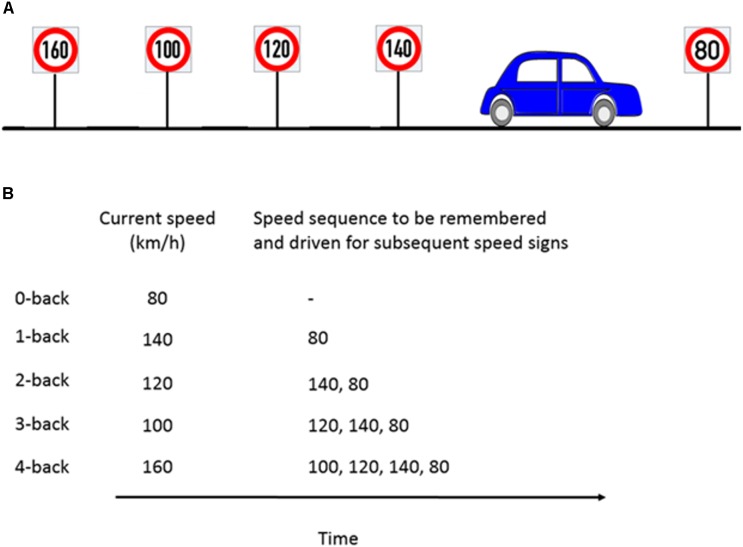
Example of the n-back experimental paradigm to manipulate cognitive workload. (A) Consider a scenario where the participant is about to pass the 80 km/h speed sign and the previous four speed signs were as shown in the schematic. (B) For the corresponding n-back task, participants had to memorize the last n speed signs and drive at the n-th speed sign which occurred previously. For example, at 1-back, the participant’s target speed is the previous sign (140 km/h) and has to keep the current speed sign in memory (80 km/h). Figure taken from Unni et al., 2017.